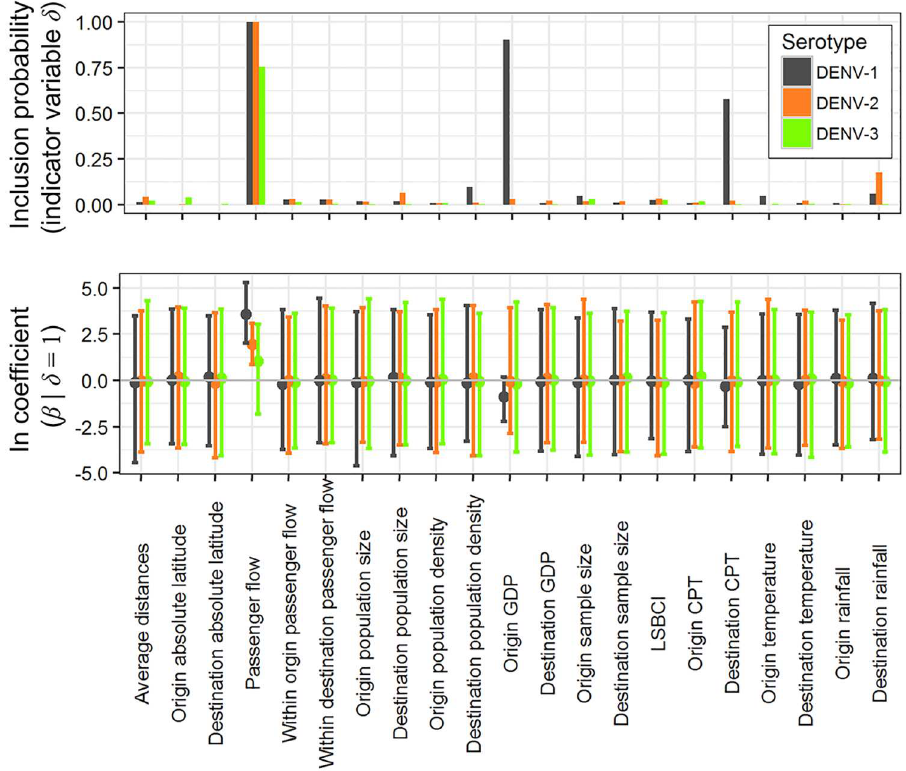
error bars indicate the mean and the 95% Bayesian credible intervals, respectively, of the estimated conditional effect size of the GLM coefficients( β | δ = 1) on a log scale, for each predictor variable. β is the effective size of the predictor variable.GDP: Gross domestic product; LSBCI: linear shippingbilateral connectivity index; CPT: containerport